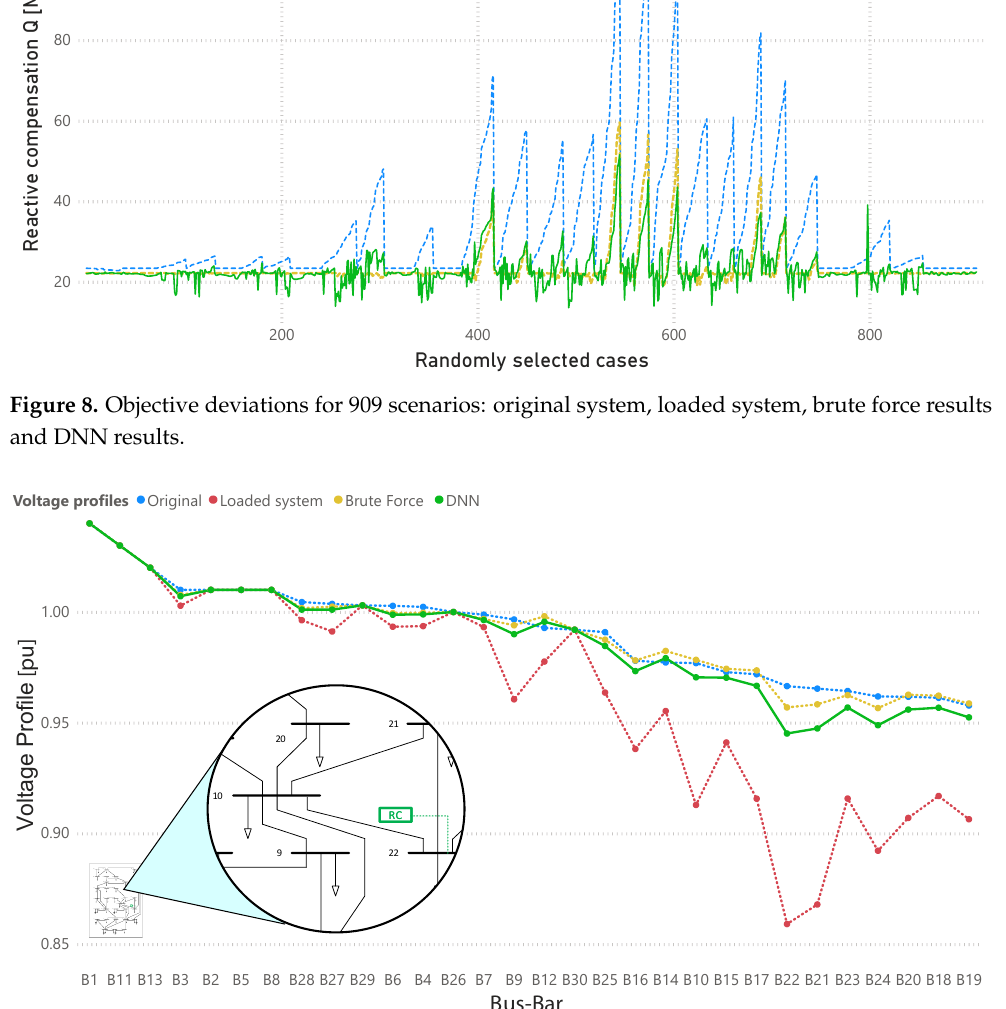
Figure 9. Voltage profiles for 30 bus-bar system: original system, loaded system, BFA and DNN compensation—BFA and DNN present similar